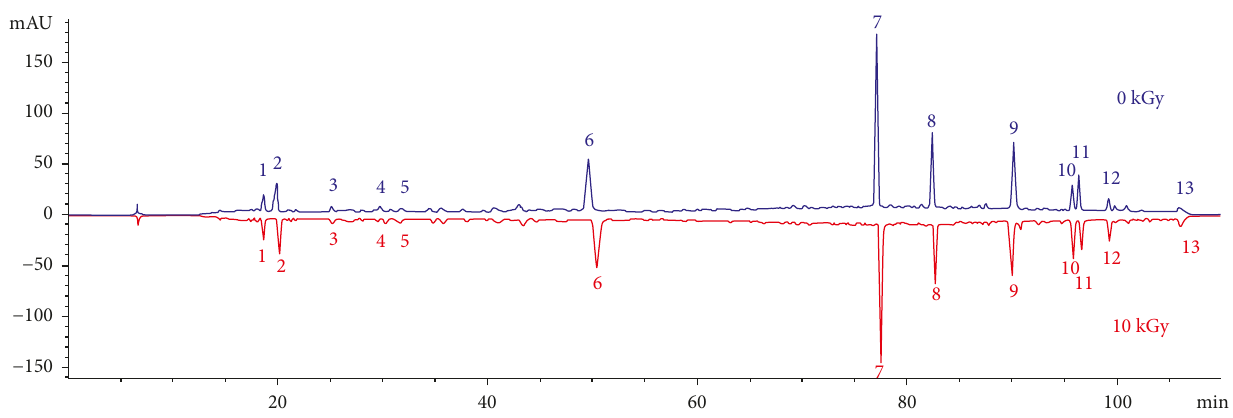
Figure 1: UPLC feature chromatograms of nonirradiated and irradiated saffron.